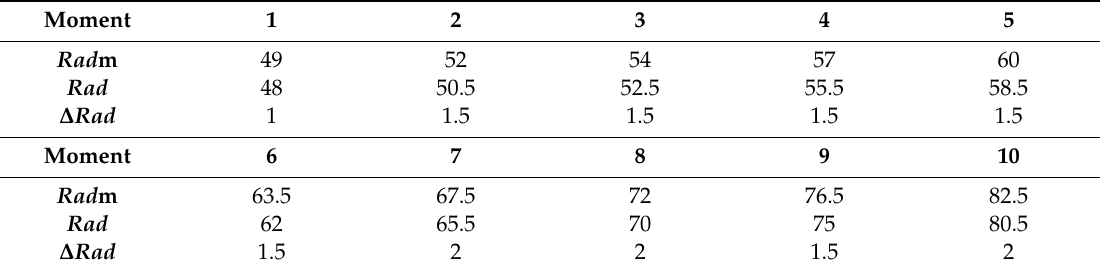
Figure 10. The trajectories of two head-on encountering ships for another 10 moments. Table 10. The danger sectors of another 10 moments in a head-on encountering scenario.